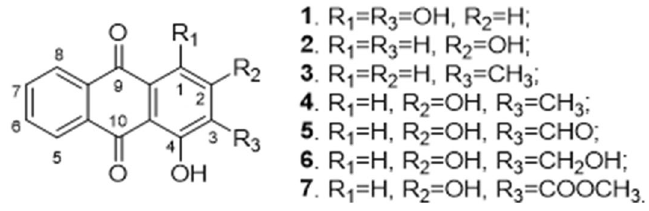
Figure 5. Chemical structures of anthraquinone derivatives found in the roots of R. wallichiana.